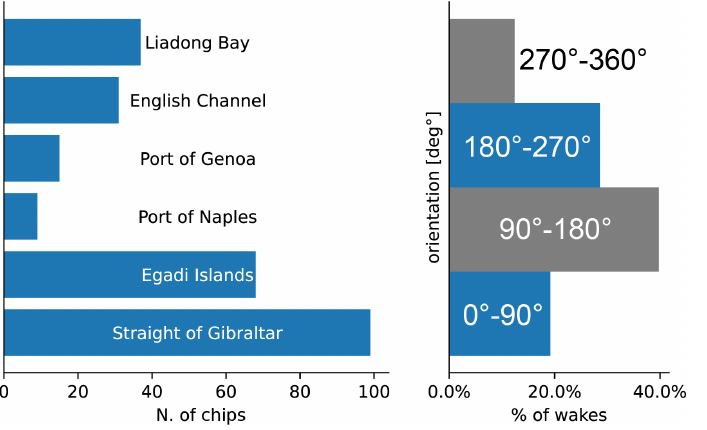
Figure 4. Statistical distribution of chip wakes across procurement sites ( left ) and orientation distribution along the four quadrants ( right ).